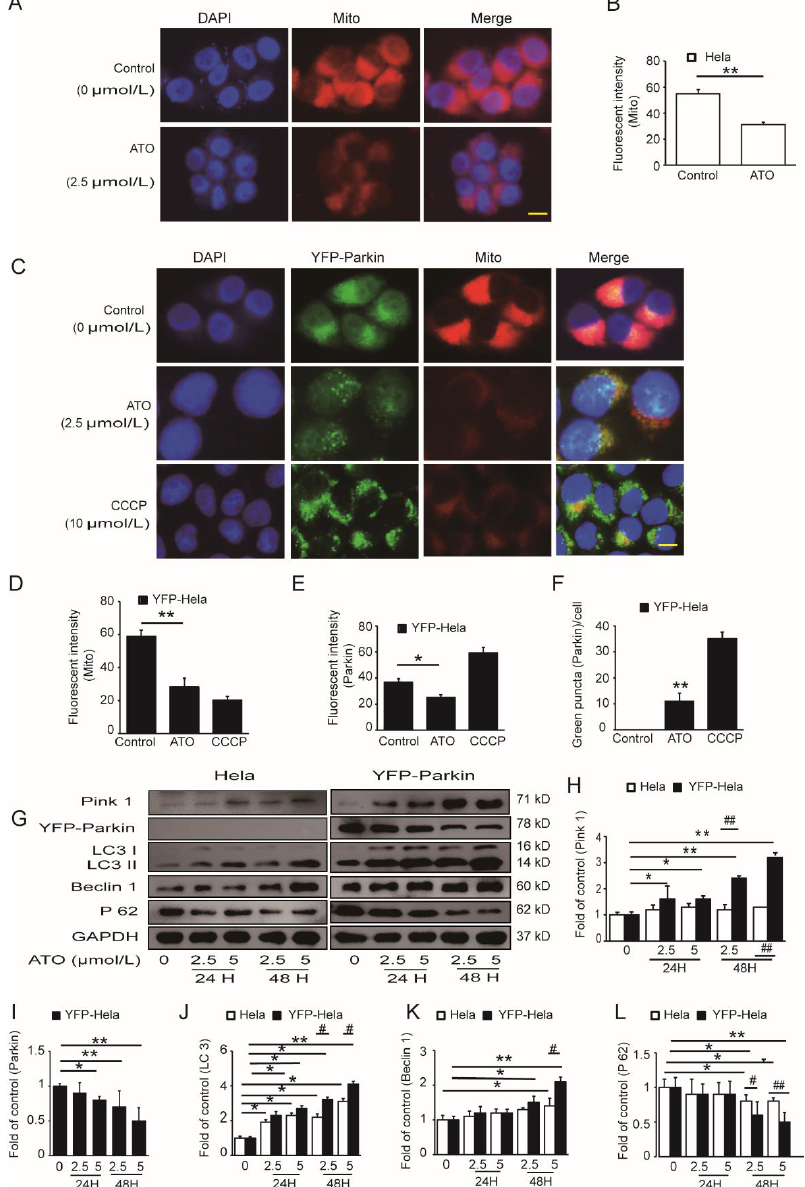
Figure 4. Regulation of PINK1/Parkin-mediated mitophagy by ATO. ( A ) HeLa cells were fixed and immunostained for nuclei (blue) and mitochondria (red) after ATO treatment for 24 h. The red fluorescence indicated the normal mitochondrial membrane potential. The samples were analyzed using a fluorescence microscopy. Scale bar, 10 µm. ( B ) shows the quantification of the red fluorescence, which was performed using Image J software. ( C ) YFP-Parkin HeLa cells were fixed and immunostained for nuclei (blue) and mitochondria (red) after ATO treatment for 24 h. The red fluorescence indicated the normal mitochondrial membrane potential. The green fluorescence was the marker for YFP-Parkin proteins. The level of mitophagy was evaluated by the number of green puncta. The samples were analyzed using a fluorescence microscopy. Scale bar, 10 µm. ( D ) Quantification of the red fluorescence, which was performed using Image J software. ( E ) Quantification of the green fluorescence, which was performed using Image J software. ( F ) Quantification of green puncta, which was performed using Image J software. ( G ) Western blot analysis of Parkin, PINK1, LC3, Beclin 1 and P62 expression in the indicated cells. ( H – L ) Quantification of G. The histograms represent the mean ± SD of triplicate experiments. * p < 0.05 vs. 0 µmol/L group, ** p < 0.01 vs. 0 µmol/L group, # p <0.05 vs. without Parkin group; ## p <0.01 vs. without Parkin group; GAPDH served as an internal control.